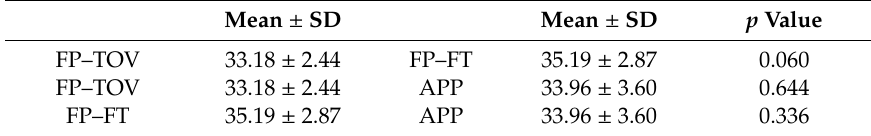
Table 3. Values of the di ff erent methods for measuring CMJ jump